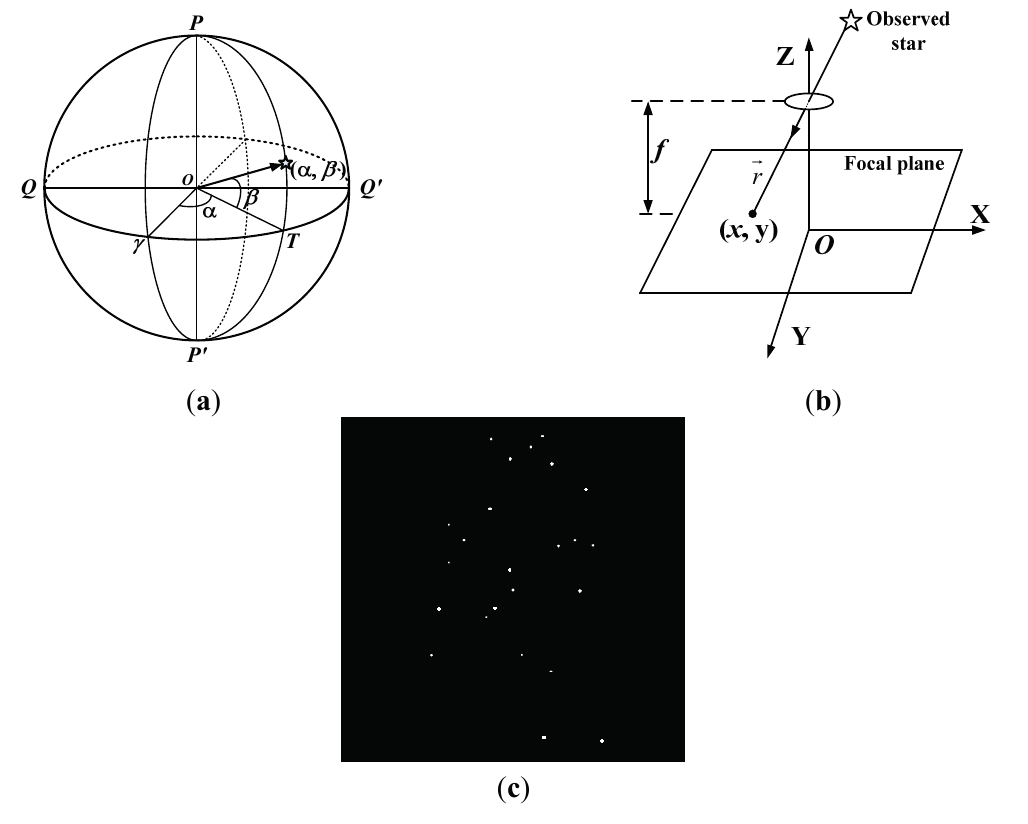
Figure 1. Stellar image in star sensor. ( a ) Celestial sphere reference frame; ( b ) The imaging principle in star sensor; ( c ) The stars observed in